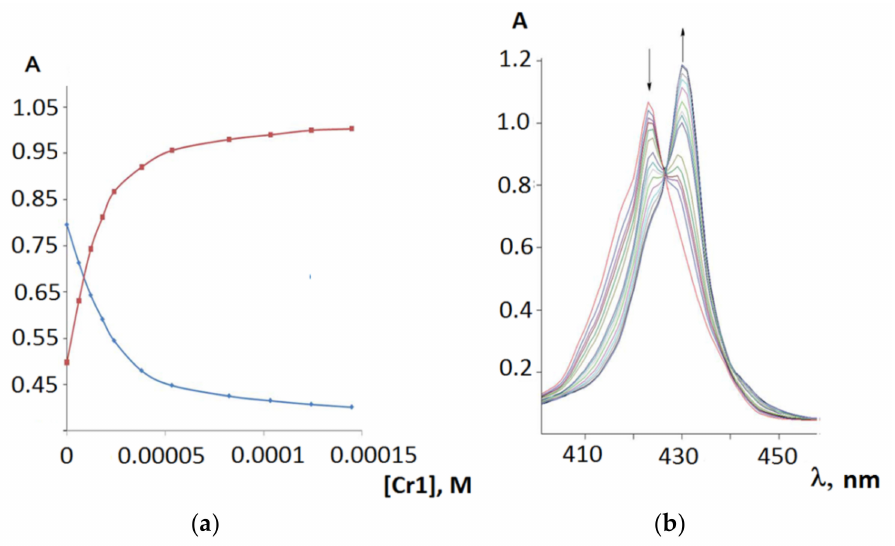
Figure 24. Titration curves ( a ) and changes in the absorption spectra ( b ) of porphyrinate 82 during the formation of a complex with the Cr1 cryptand in toluene, 20 ◦ C. [ 82 ] = 1.5 × 10 − 6 M, [Cr1] = 0 ÷ 2.9 × 10 − 4